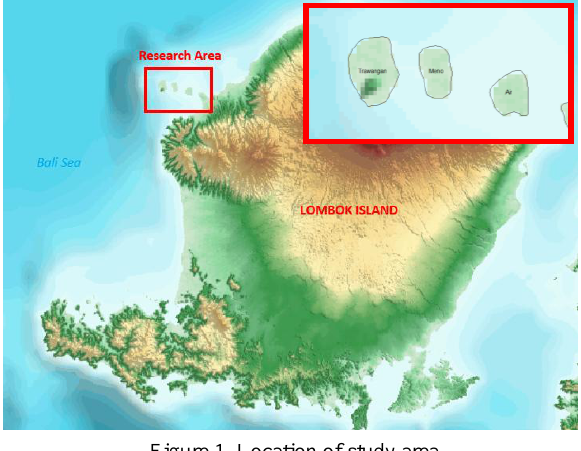
Figure 1. Location of study